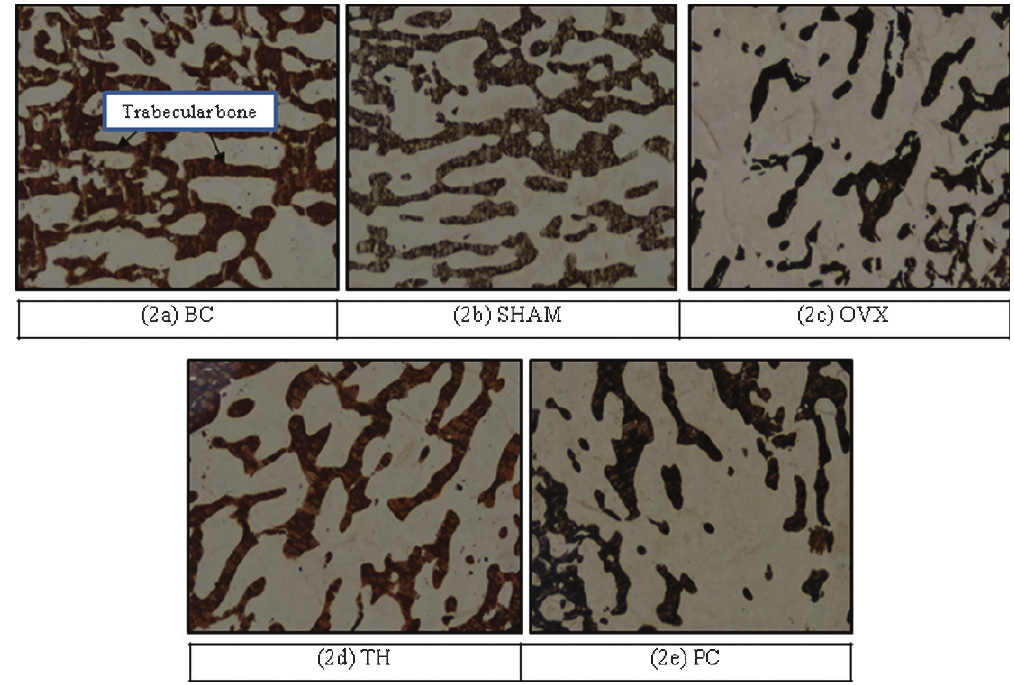
Figure 2 - Effects of Tualang honey on structure of femur bone. All pictures are stained with Von Kossa and examined under X20 magnification: BC=Baseline control group; SHAM=Sham- operated control group; OVX=Ovariectomised control group; TH=Tualang honey treated group at 0.2 g/kg/bw; PC=Positive control group (1%